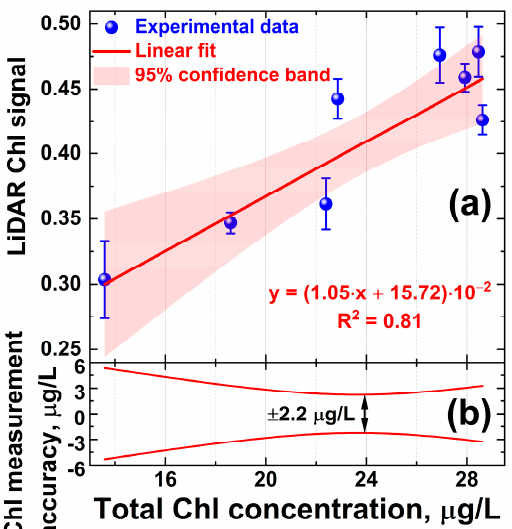
Figure 6. ( a ) LiDAR calibration curve for chlorophyll concentration measurements; ( b ) accuracy of remote chlorophyll concentration measurements by LiDAR defined as abscissa interval between the upper and lower confidence band curves at the selected ordinate value. Vertical bars in the panel ( a ) show standard deviation of the parallel measurements.